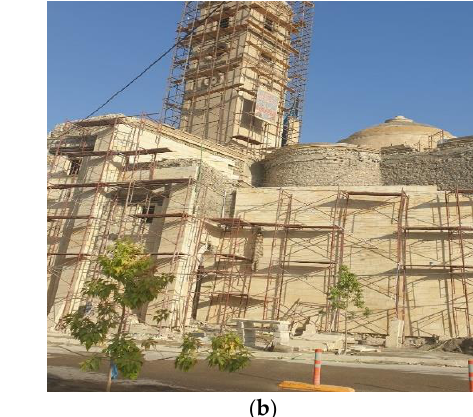
Figure 6. The vandalism of some churches and monasteries. ( a ) Mosul’s Al-Tahera Syriac-Catholic Church (photo credit: Safaaaldeen ali). ( b ) The Our Lady of the Hour Church (the Latin Church) (photo credit: Safaaaldeen ali).